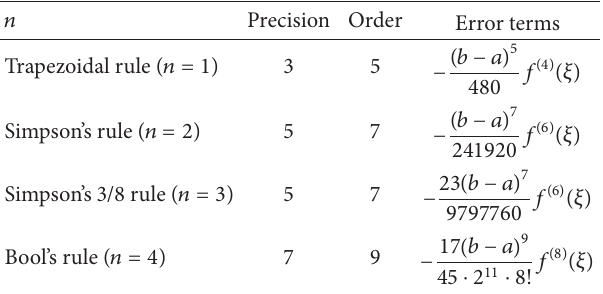
Table 1: Precision, the orders and the error terms for midpoint derivative-based closed Newton-Cotes